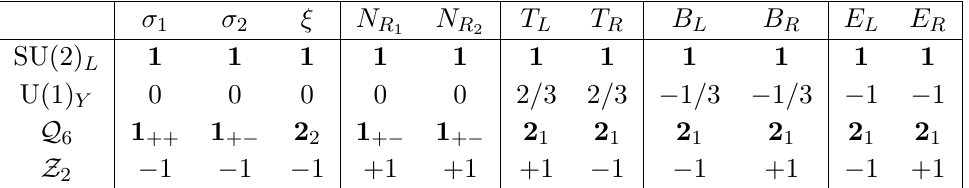
Table 1. Charge assignments of the SU(2) scalar doublets and SM fermions under the symmetry, Q × Z 6 2 . We have arranged the ≡ ( L , d R ( d R ) T , L L L 1 , L L 2 ) 1 2 D